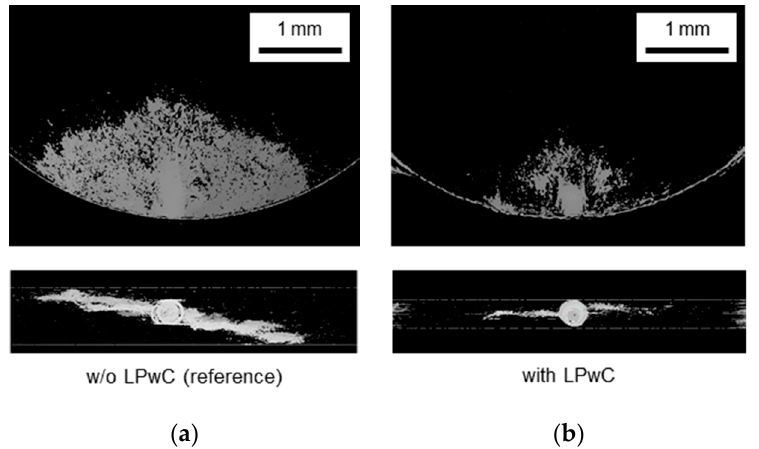
Figure 6. Three-dimensional (3D) crack images of AC4CH fatigue samples: ( a ) The crack in the